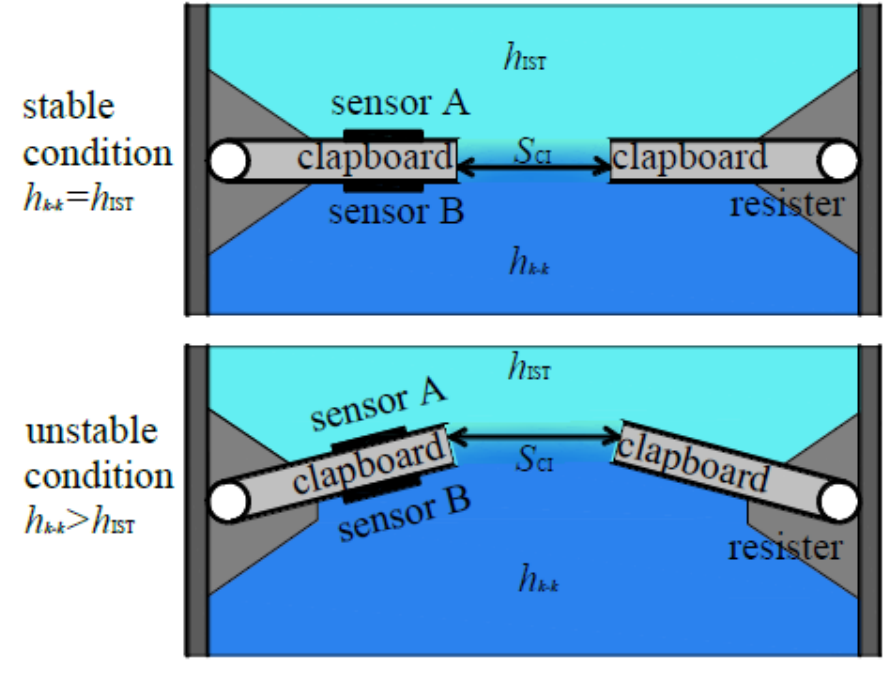
Figure 9. Mechanism of the flow damper in the IST.